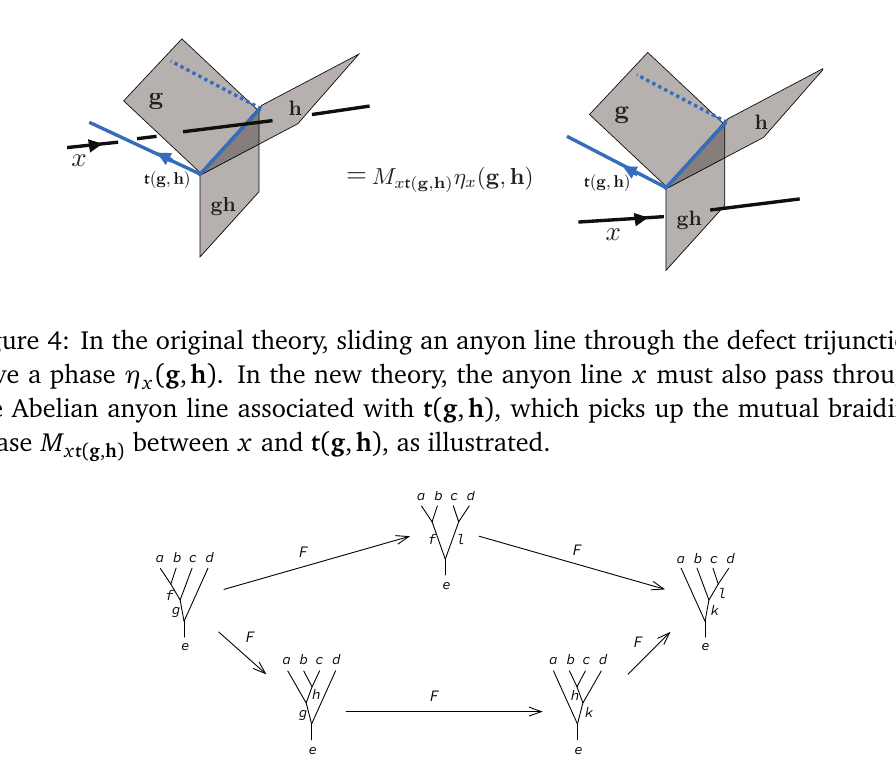
Figure 5: The Pentagon equation enforces the condition that different sequences of F -moves from the same starting fusion basis decomposition to the same ending decomposition gives the same result. Eq. (42) is obtained by imposing the condition that the above diagram commutes.